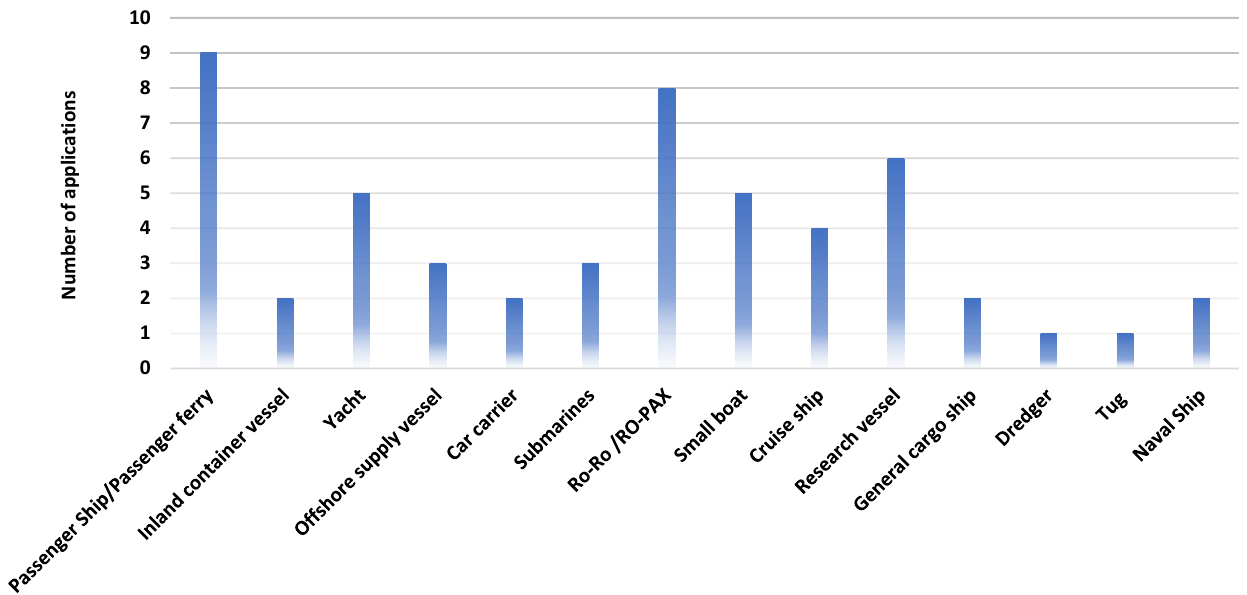
Figure 8. Number of applications for different ship types operated by fuel cell systems.